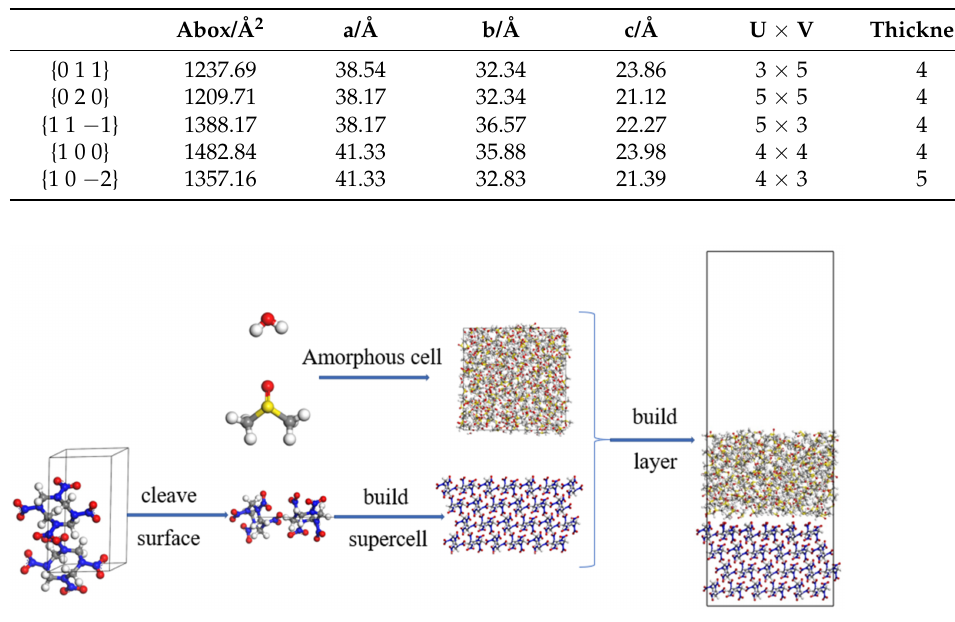
Figure 1. The modeling process of {1 1 − 1} crystal plane in DMSO–water binary